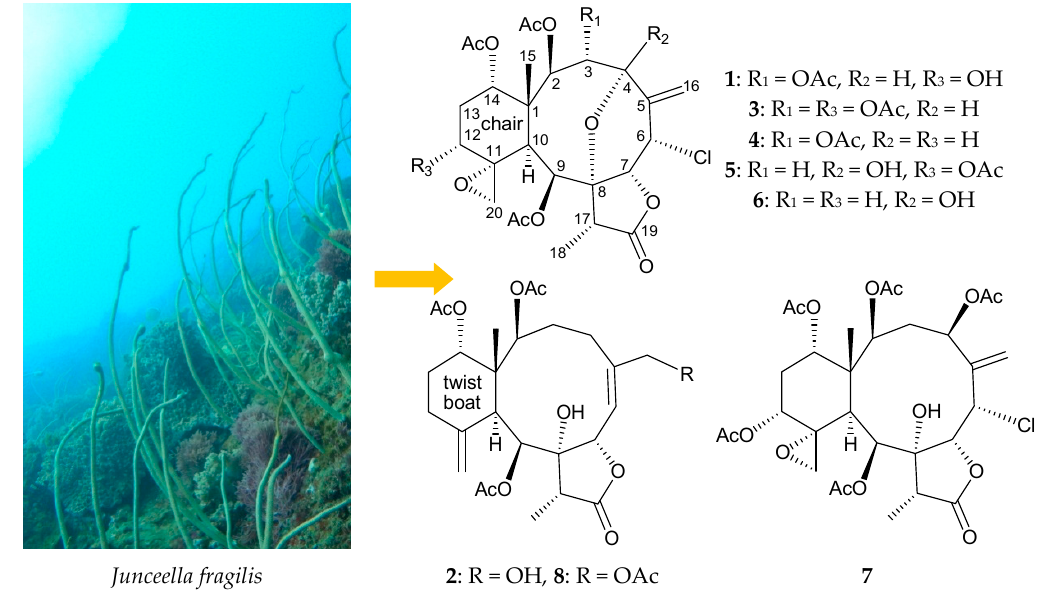
Figure 1. Gorgonian coral Junceella fragilis and structures of fragilides K ( 1 ) and L ( 2 ), gemmacolide X ( 3 ), praelolide ( 4 ), juncins P ( 5 ) and ZI ( 6 ), gemmacolide V ( 7 ), and junceellonoid B ( 8 ).